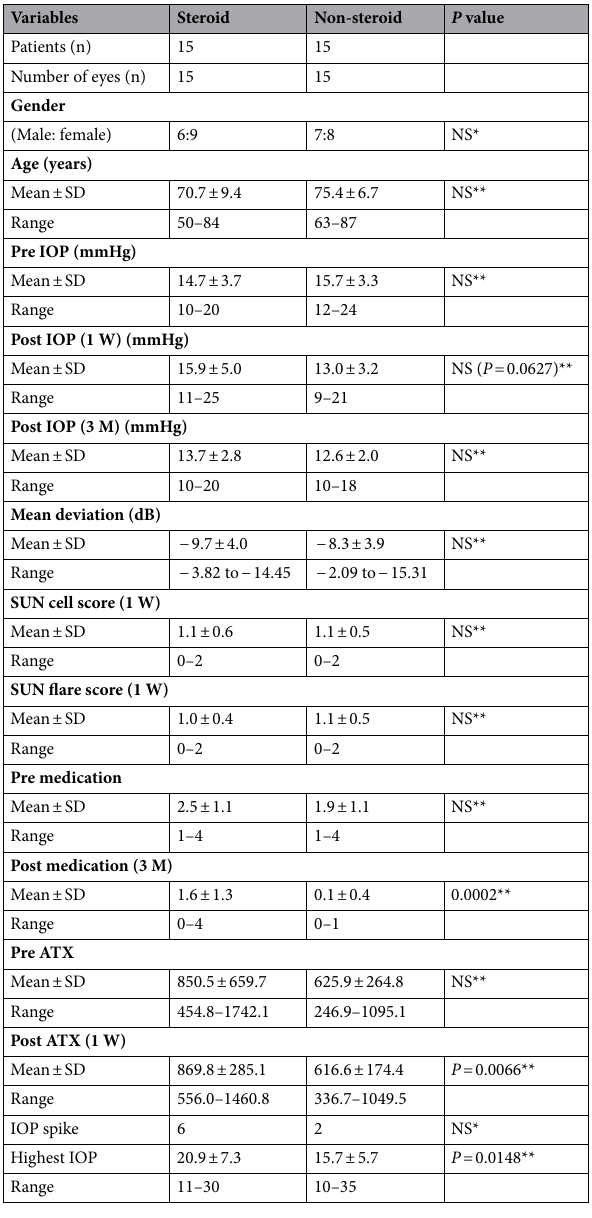
Table 1. Demographic characteristics and preoperative and postoperative values. Pre preoperative; Post postoperative; 1 W 1 week; SD standard deviation; IOP intraocular pressure; ATX autotaxin. IOP spike: > 25 mmHg. *Fisher’s exact test, **Mann–Whitney U